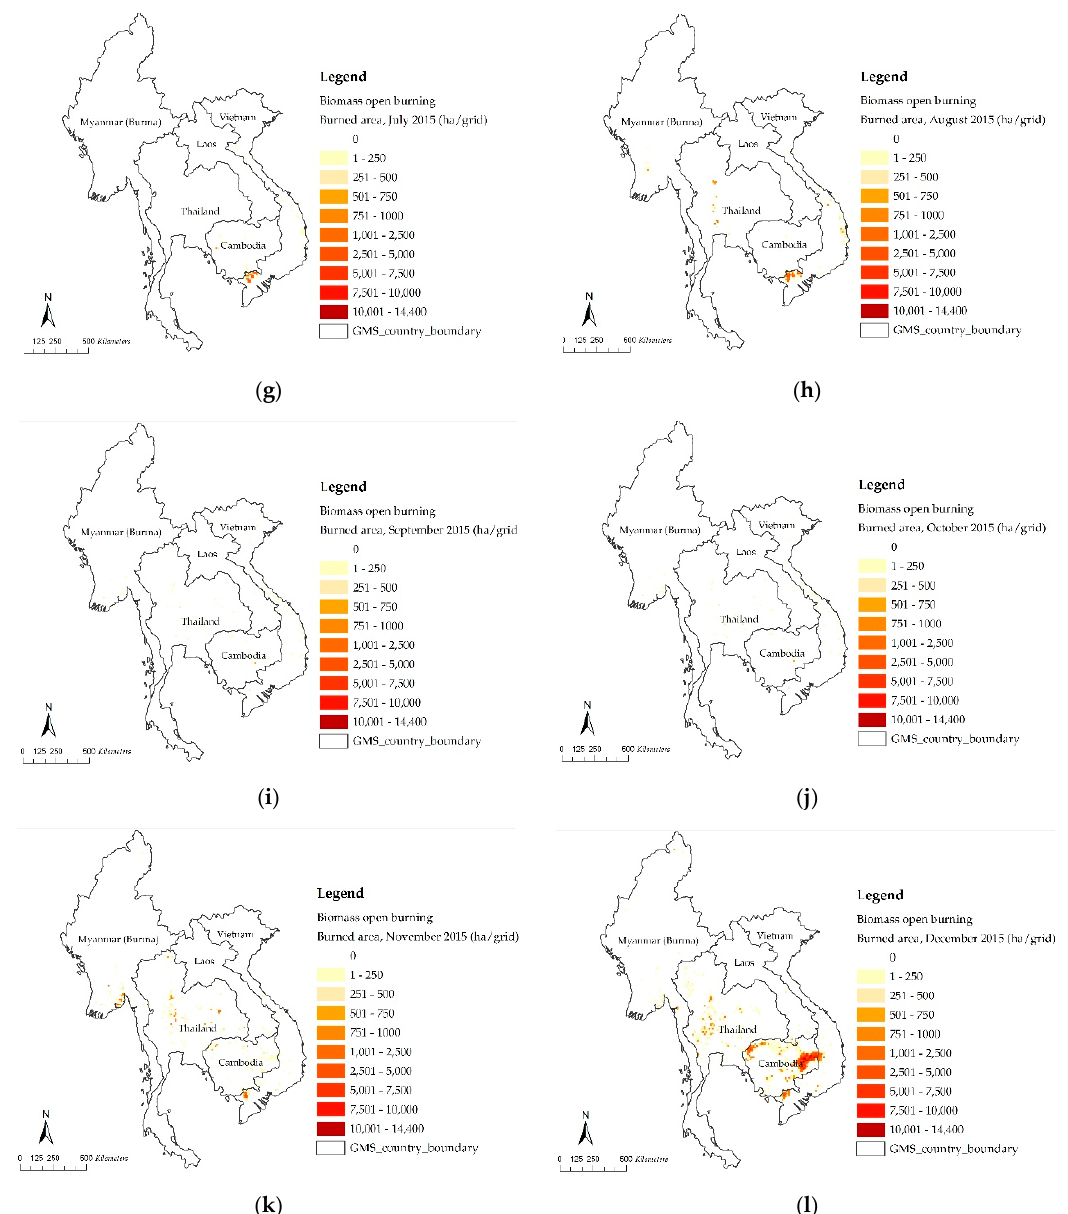
Figure 5. Spatial and monthly temporal distribution of the burnt areas occurring in ( a ) January, ( b ) February, ( c ) March, ( d ) April, ( e ) May, ( f ) June, ( g ) July, ( h ) August ( i ) September, ( j ) October, ( k ) November, and ( l ) December